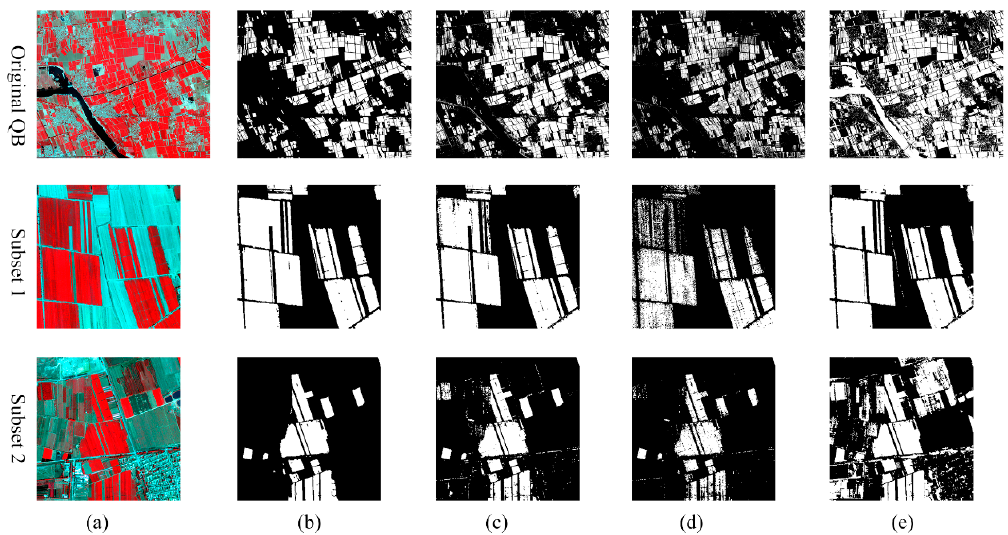
Figure 5. Comparison wheat classification results of different methods ( a ) Original remote sensing image; ( b ) reference result as actual data; ( c ) support vector machine (SVM) classification result; ( d ) WVS-SVDD classification result; ( e ) traditional SVDD method.